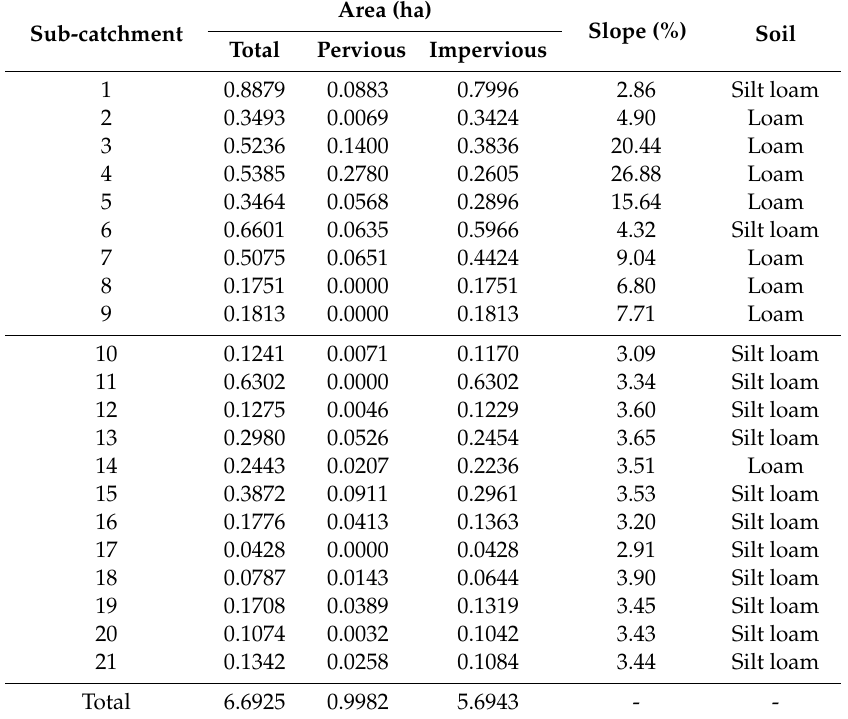
Table 1. Characteristics of